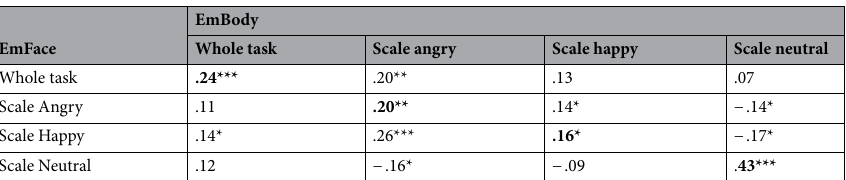
Table 3. Correlations between scores in the EmBody and the EmFace. Scores were collected at Session 1. Asterisks indicate statistically significant Spearman rank ( r S ) correlation coefficients: * p < .05, ** p < .01, *** p < .001. Correlations for corresponding scales are printed in bold